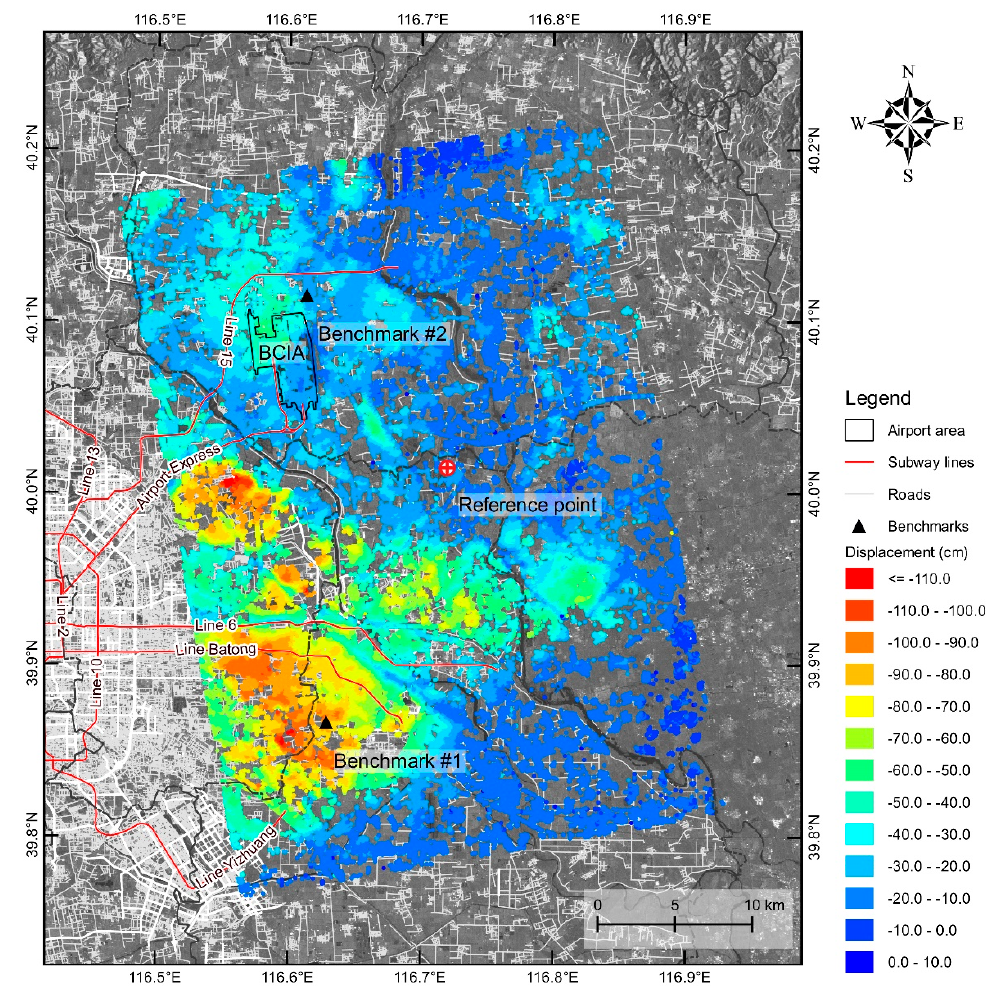
Figure 4. Vertical displacement map superimposed on synthetic aperture radar (SAR) reflectivity in the eastern Beijing Plain area. The red lines represent subway lines and the black triangles indicate the benchmarks used for comparison purposes in Figure 6.